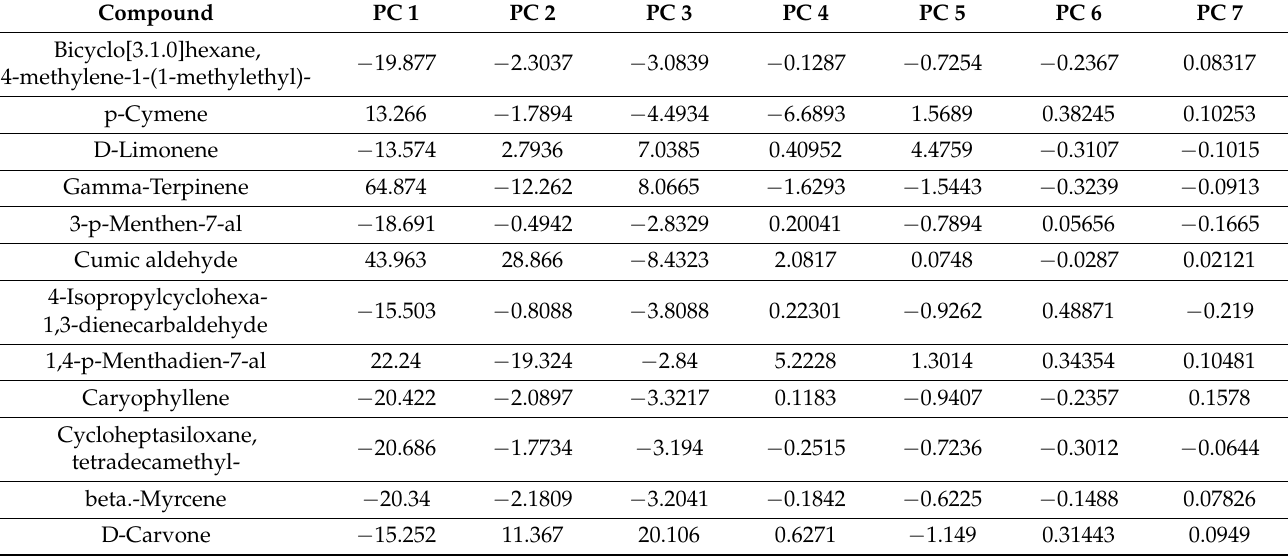
Table 2. Principal component analysis (PCA) scores showing correlation coefficients for the variables loaded between the rows for 12 different compound variables and the columns for seven climate zones of North Western Himalayas